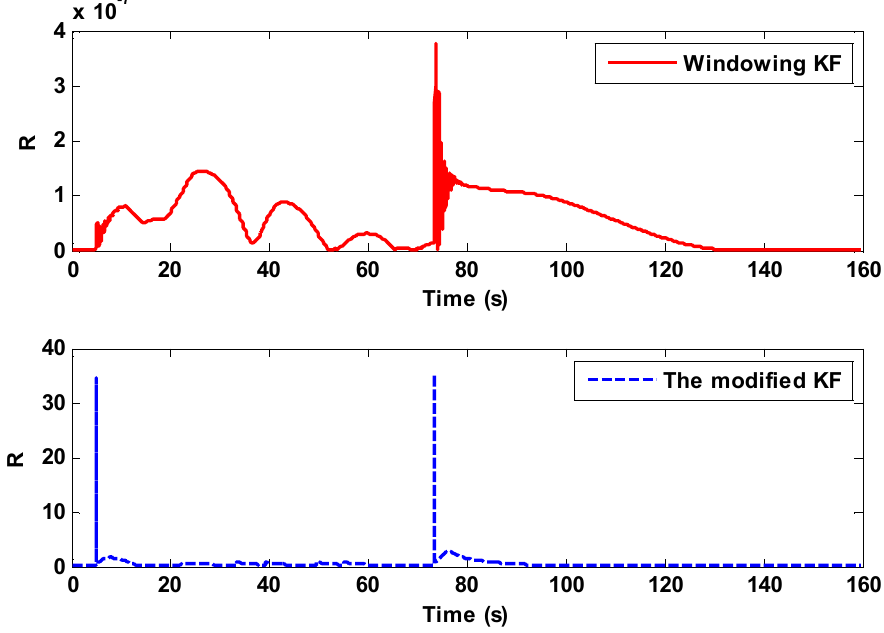
Figure 8. Comparison for updating R for proposed KF methods (for voltage magnitude signal).